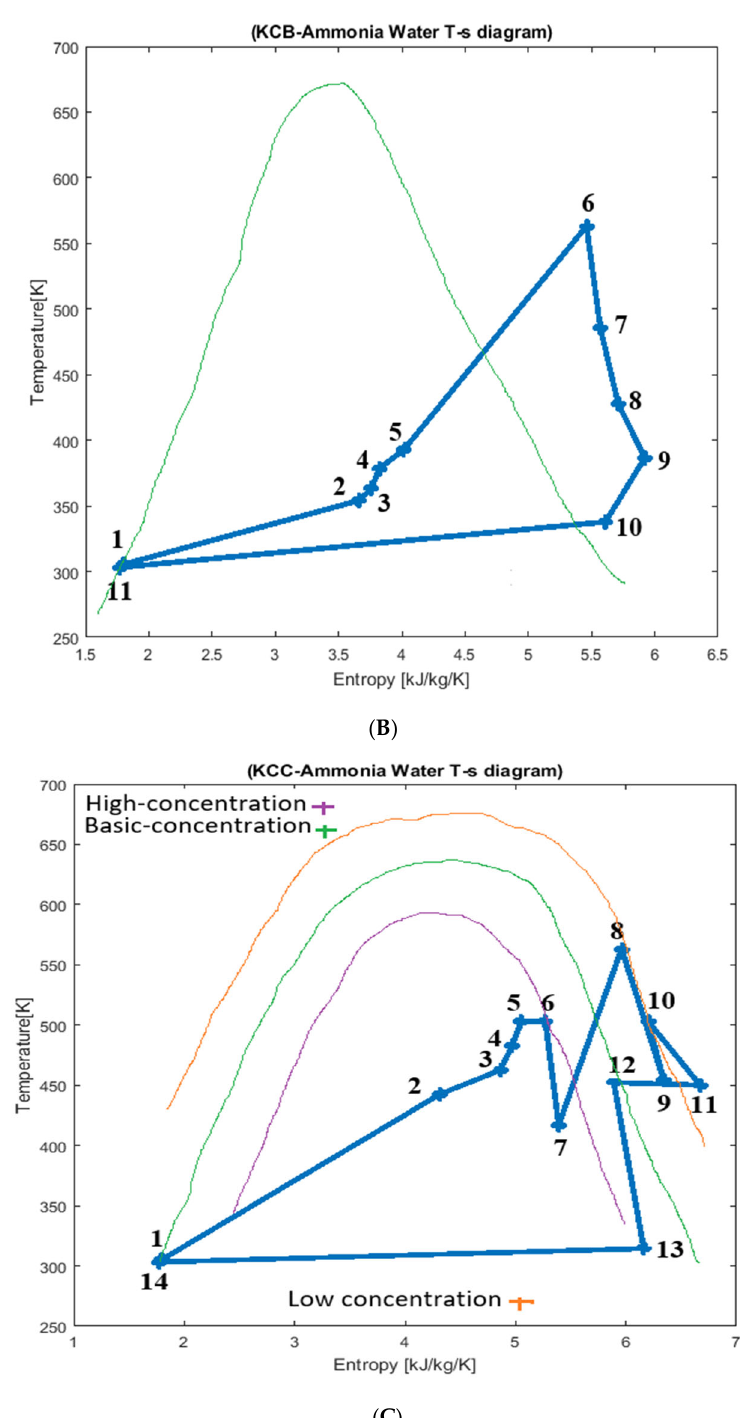
Figure 4. T–s diagrams of KCA ( A ), KCB ( B ), and KCC ( C ).